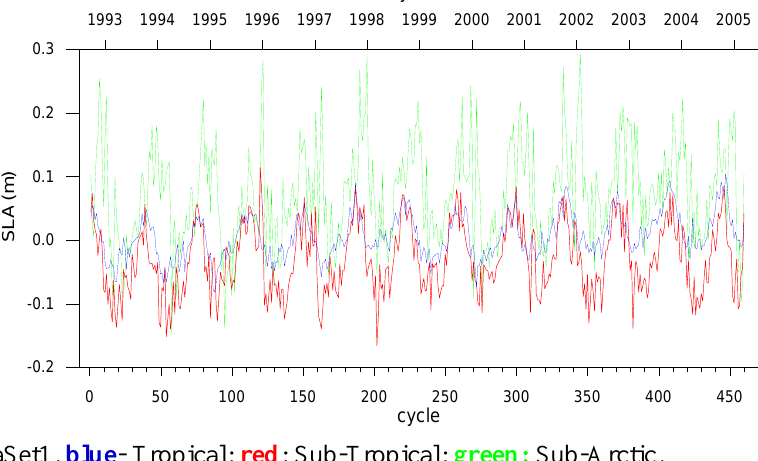
Figure 2. SLA for DataSet1. blue - Tropical; red : Sub-Tropical; green: Sub-Arctic.